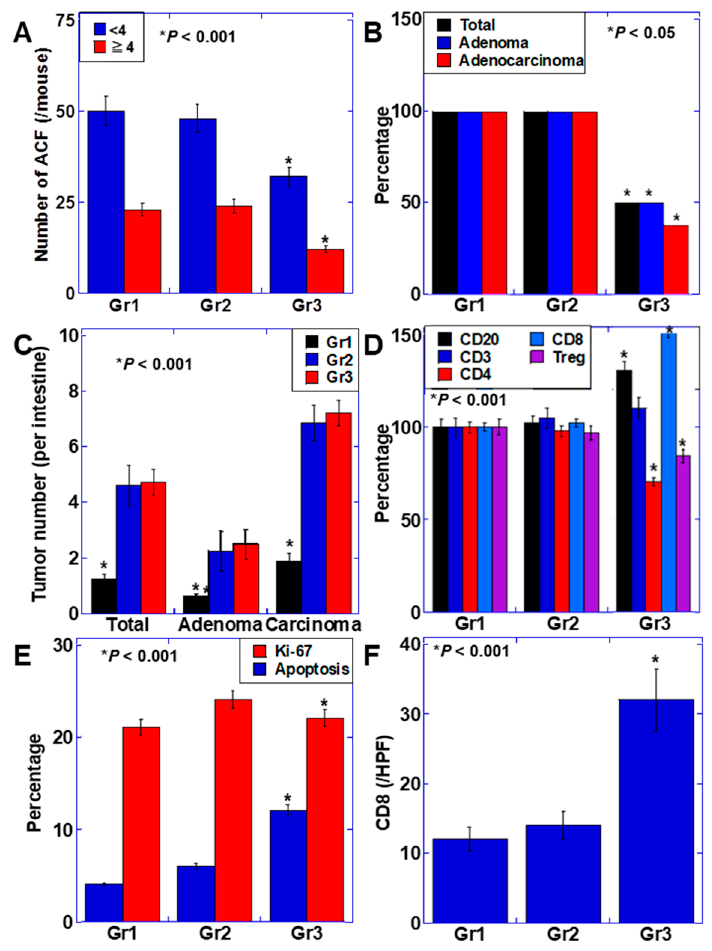
Figure 4. Effect of BCM on colon carcinogenesis in mice. ( A ) Number of ACF lesions in 10 mice at week 20. ACF was divided into clusters of <4 foci and ≥ 4 foci. ( B ) Percentage of tumor formation in 10 mice. ( C ) Number of adenoma and adenocarcinoma. ( D ) Lymphocyte subsets of the intestinal mucosa from which the tumor was removed. Differentiation markers were examined by ELISA. ( E , F ) Cell proliferation (Ki-67), apoptosis, and CD8 + T cells were examined by immunostaining. Error bar, standard deviation from three independent trials. BCM, β -casomorphin-7; ACF, aberrant crypt foci; TOP, thiorphan; Gr, group; ELISA, enzyme-linked immunosorbent assay; Treg, regula- tory T cell.